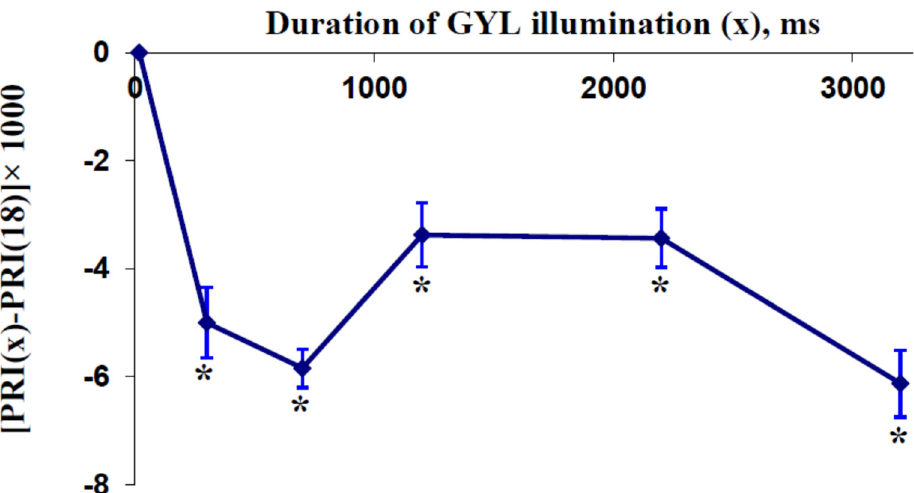
Figure 11. Dependence of green-yellow light (GYL)-induced changes in PRI on the duration of the illumination ( n = 8). GYL-induced changes were calculated as [PRI(x)-PRI(18)], where PRI(x) was PRI at the GYL illumination with duration equaling to x ms and PRI(18) was PRI with the GYL illumination with duration equaling to 18 ms. * indicates that [PRI(x)-PRI(18)] was significantly differed ( p < 0.05) from 0. n is number of repetitions. Bars show standard errors.